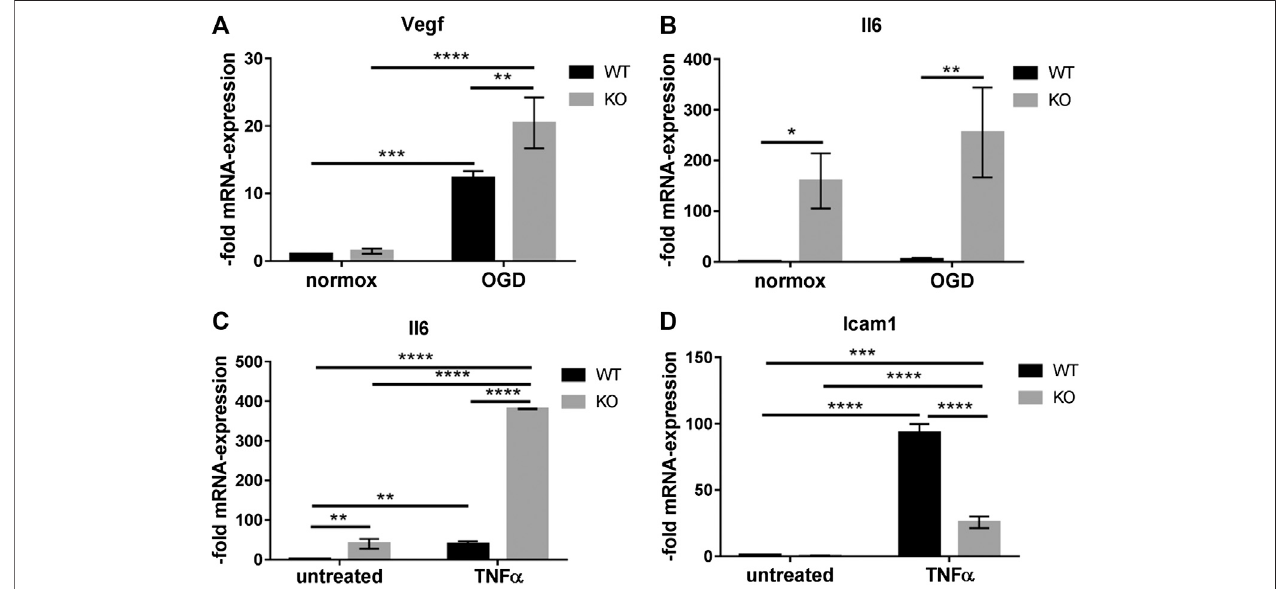
FIGURE 6 | PcdhgC3 knockout Brain Microvascular Endothelial Cells respond stronger to oxygen/glucose deprivation (OGD) conditions and to Tumor Necrosis Factor Alpha treatment. Con fl uent wild type (WT) and PcdhgC3 knockout (KO) BMECs were subjected to OGD (A,B) or TNF α treatment (C,D) followed by RNA extraction and qPCR analysis of indicated markers. Target gene expression was normalized to endogenous control and shown as fold over control (untreated WT cells for TNF α and normoxic WT cells for OGD), which was arbitrarily set as 1. Data are shown as mean ± standard deviation of three independent experiments. Icam1, Intracellular adhesion molecule; Il6, Interleukin 6; TNF α , Tumor necrosis factor alpha; Vegf, Vascular endothelia growth factor. * p < 0.05, ** p < 0.01, *** p < 0.001, **** p <